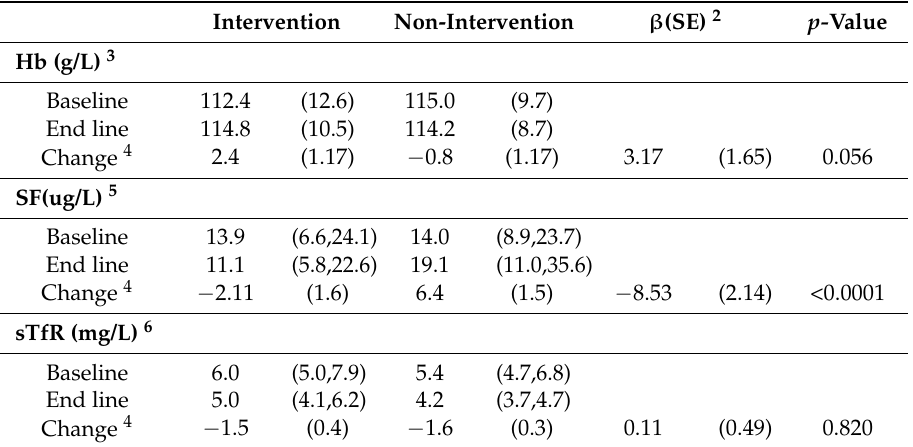
Table 3. Change in iron status during the intervention period 1 .